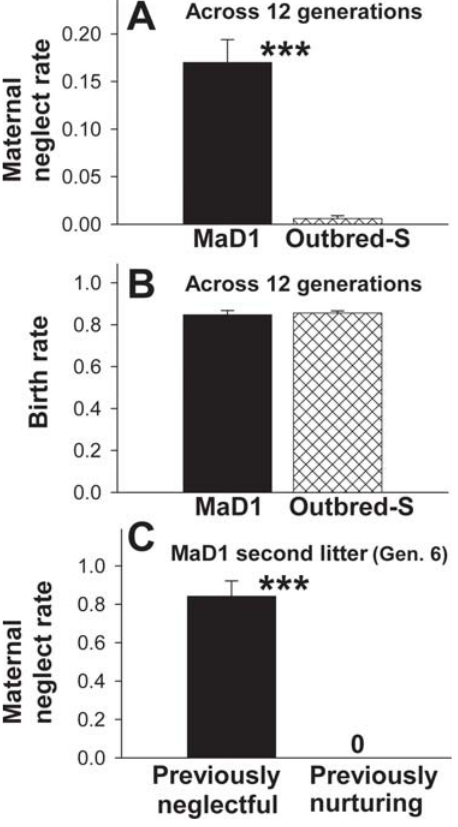
Figure 1. Maternal neglect rate in MaD1 mice. Maternal neglect rate (neglect leads to death of all pups in a litter) was significantly higher in MaD1 relative to Outbred-S mice when examined over 12 generations (A). Birth rate (number of male-female pairings relative to number of litters born) is almost identical between MaD1 and Outbred- S mice when examined over 12 generations (B). When raising a second litter (examined in Generation 6), previously neglectful mice exhibited significantly higher levels of maternal neglect relative to previously